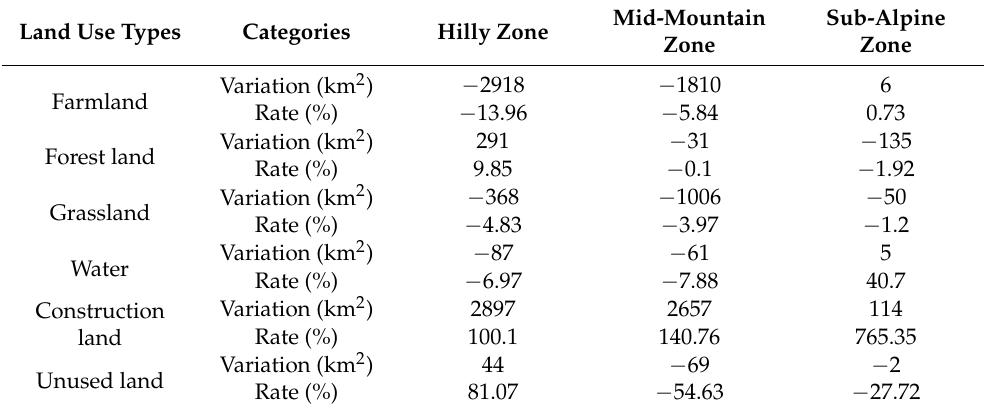
Table 4. Land use changes in the different geomorphic zones from 1980 to